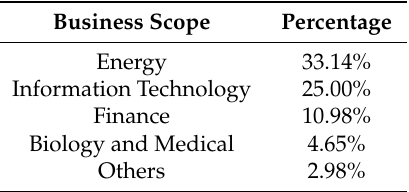
Table 3. Distribution of 172 target companies,